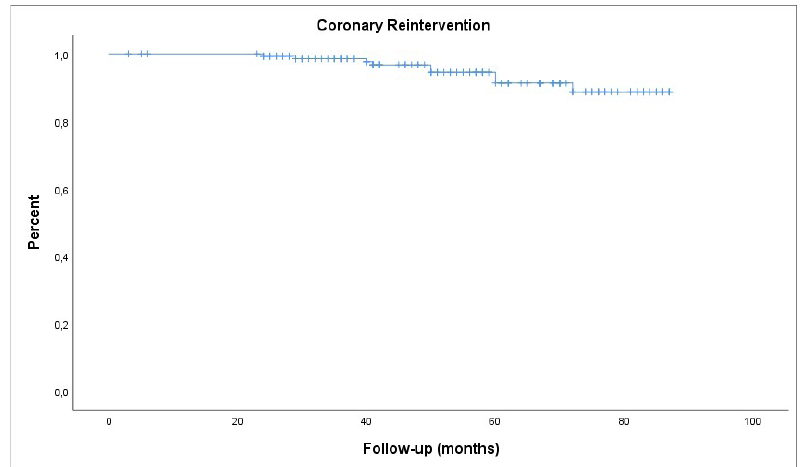
Fig. 2 - Kaplan-Meier analysis of freedom from coronary reintervention in all